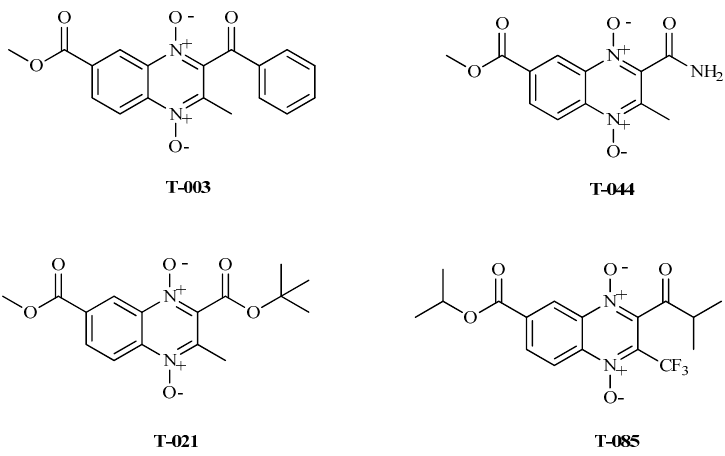
Figure 2. Structure of quinoxaline-7-carboxylate derivatives tested as TR inhibitors. T-003 , T-021 and T-044 were previously reported with trypanocidal activity by Villalobos-Rocha et al.